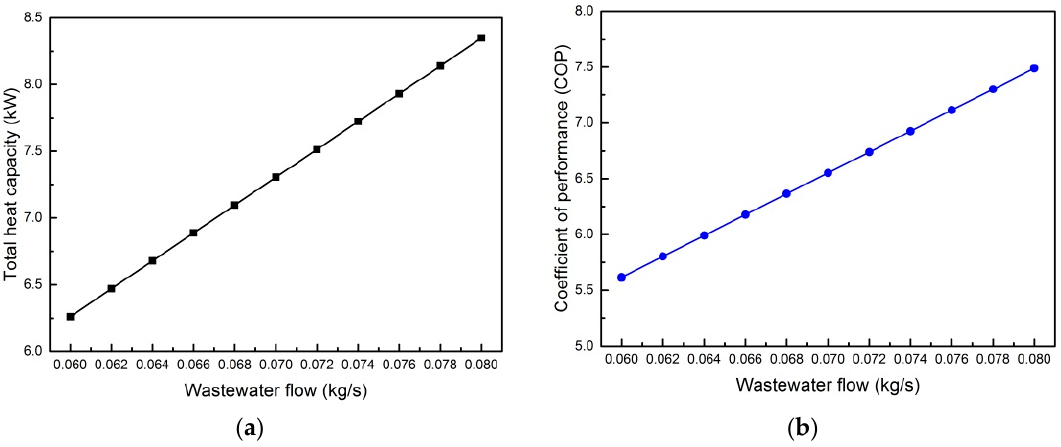
Figure 9. Influence of wastewater flow rate on total heat capacity and COP: ( a ) Total heat capacity; ( b ) COP.